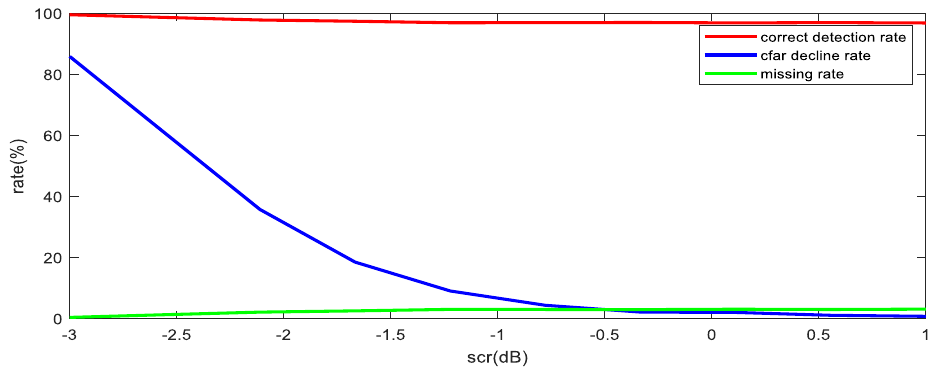
Figure 10. The change of the performance indexes along with SCR.